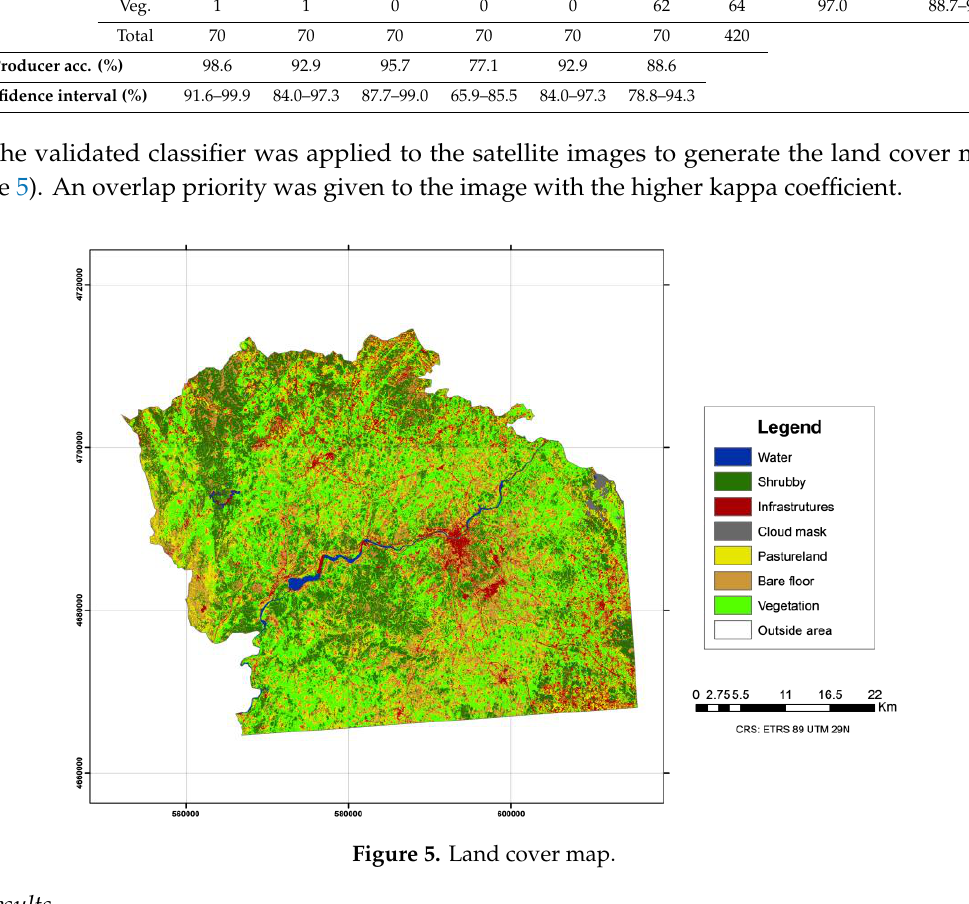
Figure 6. Land surface temperature map. The geological map (Figure 7) was created according the procedure described in Section 2.1.3. For the MAGNA re-georeferencing a total, thirty-six points were employed and distributed as homogeneously as possible for an optimal calculation and reprojection. The three-sigma criterion was applied to discard possible outliers [54].